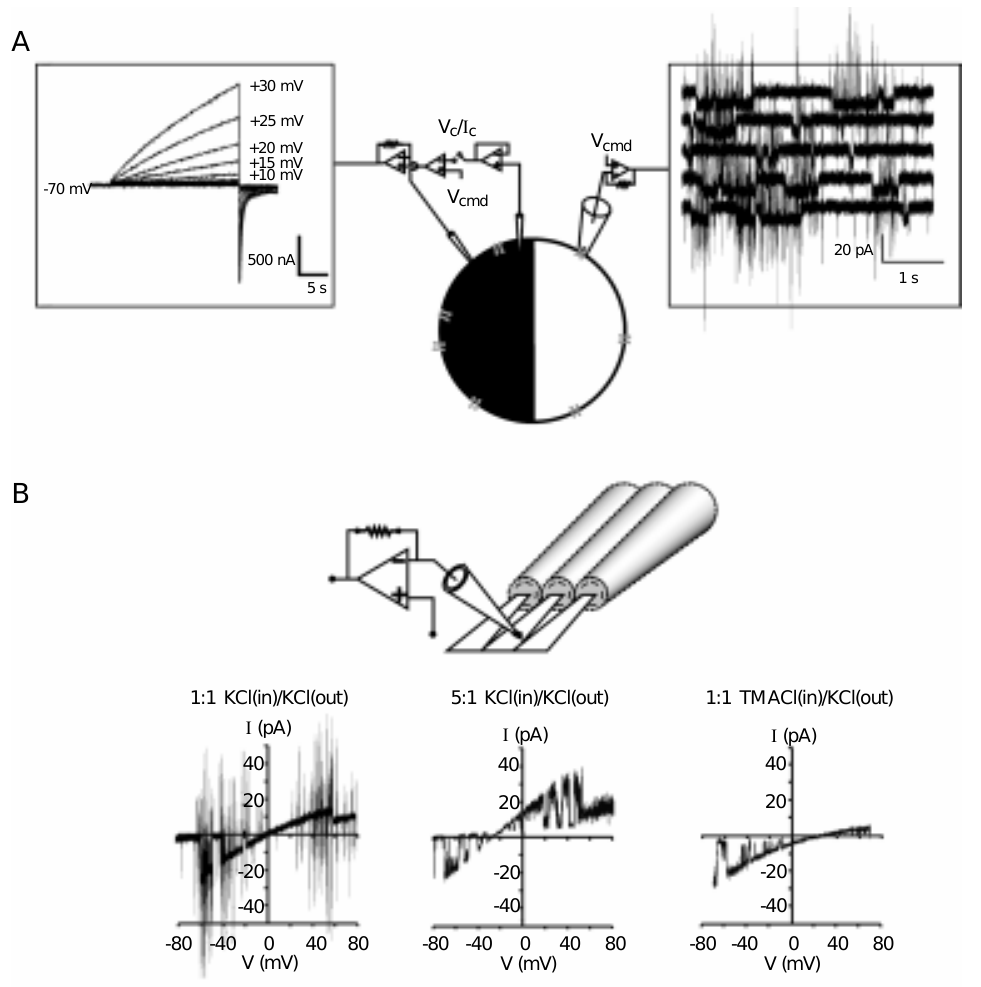
Figure 1 - Hemichannels provide a means of studying connexin properties. A , Examples of mac- roscopic and single channel re- cordings of Cx46 currents from Xenopus oocytes. B , Conduc- tance and permeability can be examined rigorously using ex- cised patches. A schematic drawing shows a multi-barrel perfusion system that was used to change solutions applied to excised patches containing hemichannels. Examples of re- cordings in symmetric and a- symmetric conditions show changes in open channel I-V re- lations and shifts in reversal po- tential consistent with Cx46 hemichannels being cation se-